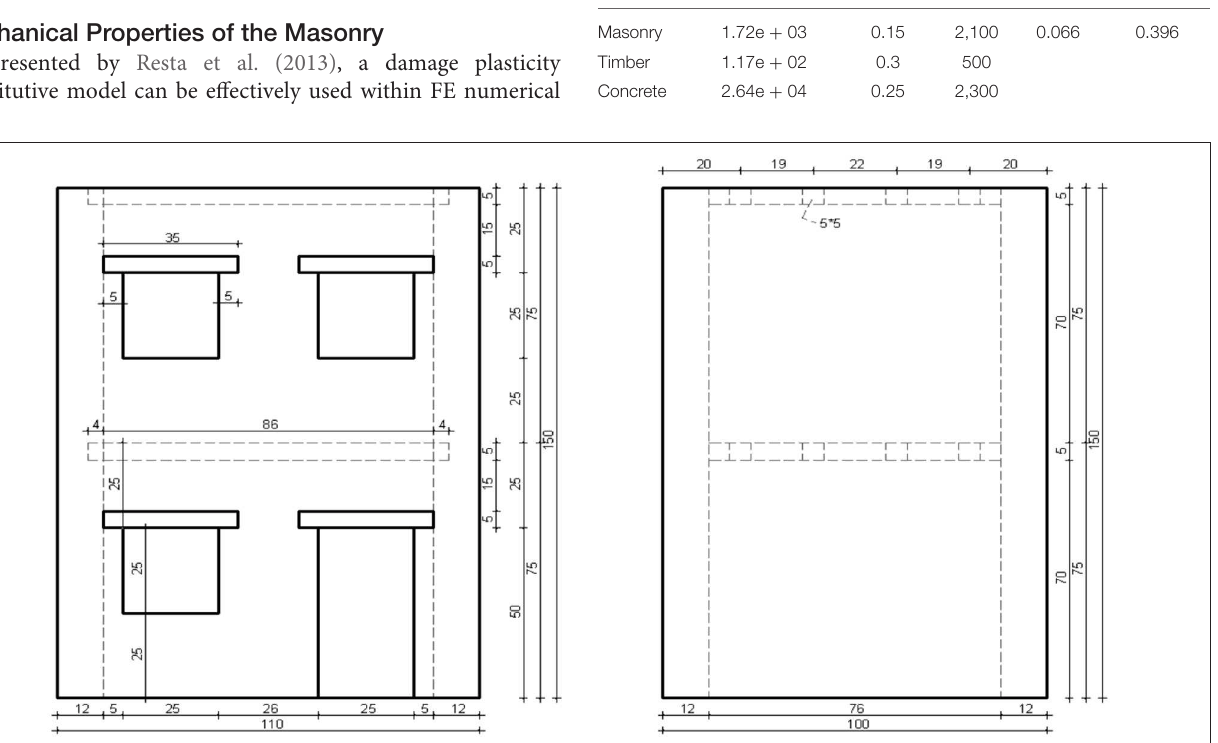
FIGURE 4 | Side views (dimensions in cm) of the tested models (Tomazevic et al., 1996).